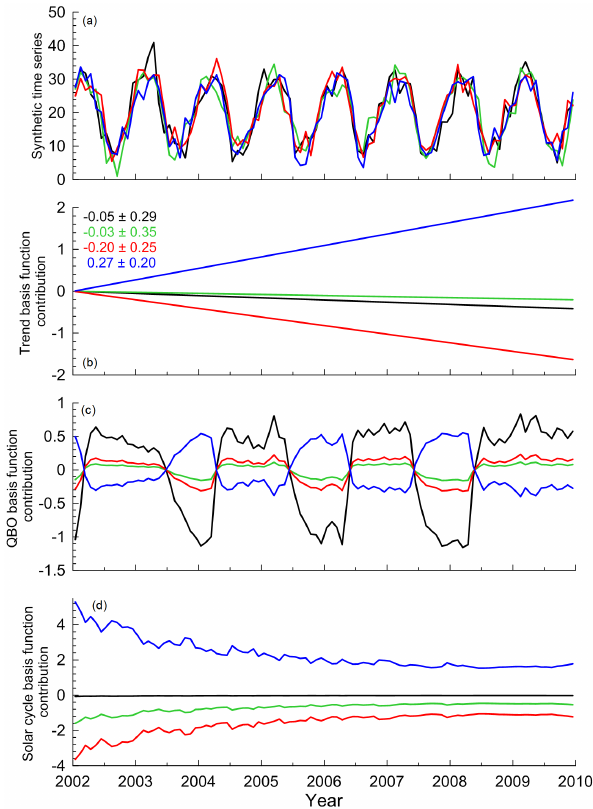
Figure 3. Four synthetic monthly mean time series calculated by adding Gaussian distributed random noise to a repeating mean an- nual cycle (a) together with the contributions from the trend (b) , QBO (c) and solar cycle (d) basis function derived by fitting Eq. (1) to the time series in (a) . The quantity plotted is artificial and there- fore unitless. The trend values listed in (b) include their 1 σ uncer-